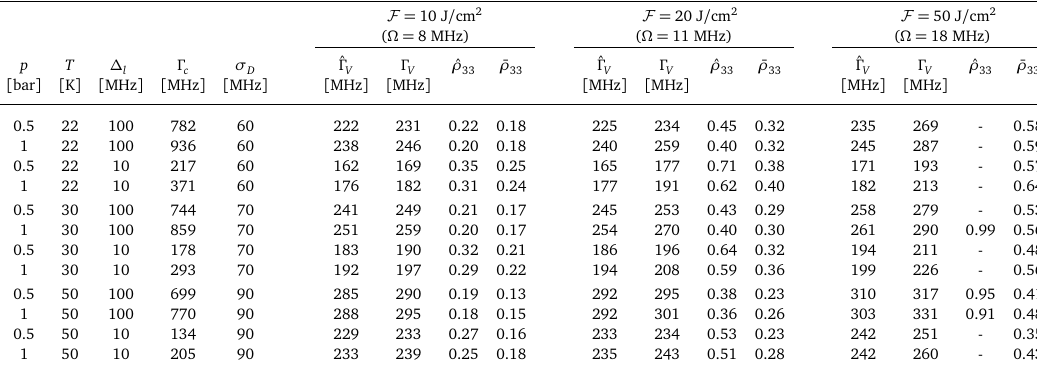
Table 6: Same as Table 4 but for a statistical ortho- to para-distribution of the initial rotational states of H molecules. 2